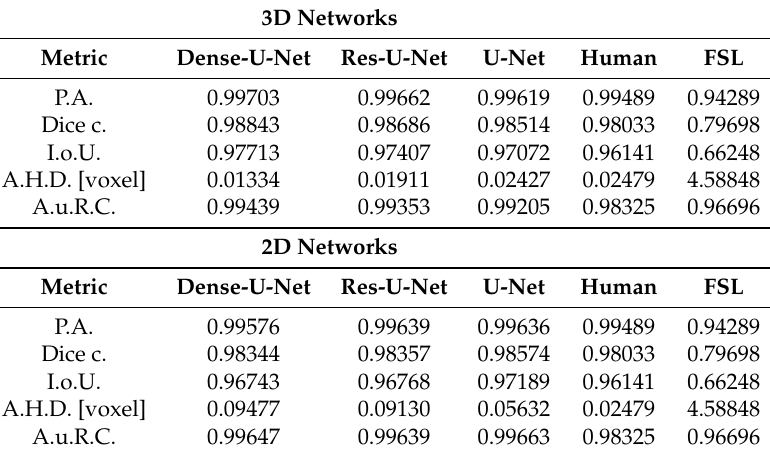
Comparison of tested U-Net versions on brain dataset in benchmark training phase versus Human expert and FMRIB’s Automated Segmentation Tool. Used metrics—pixel accuracy, Dice coefficient, intersection over union, average Hausdorff distance [voxel] and area under ROC